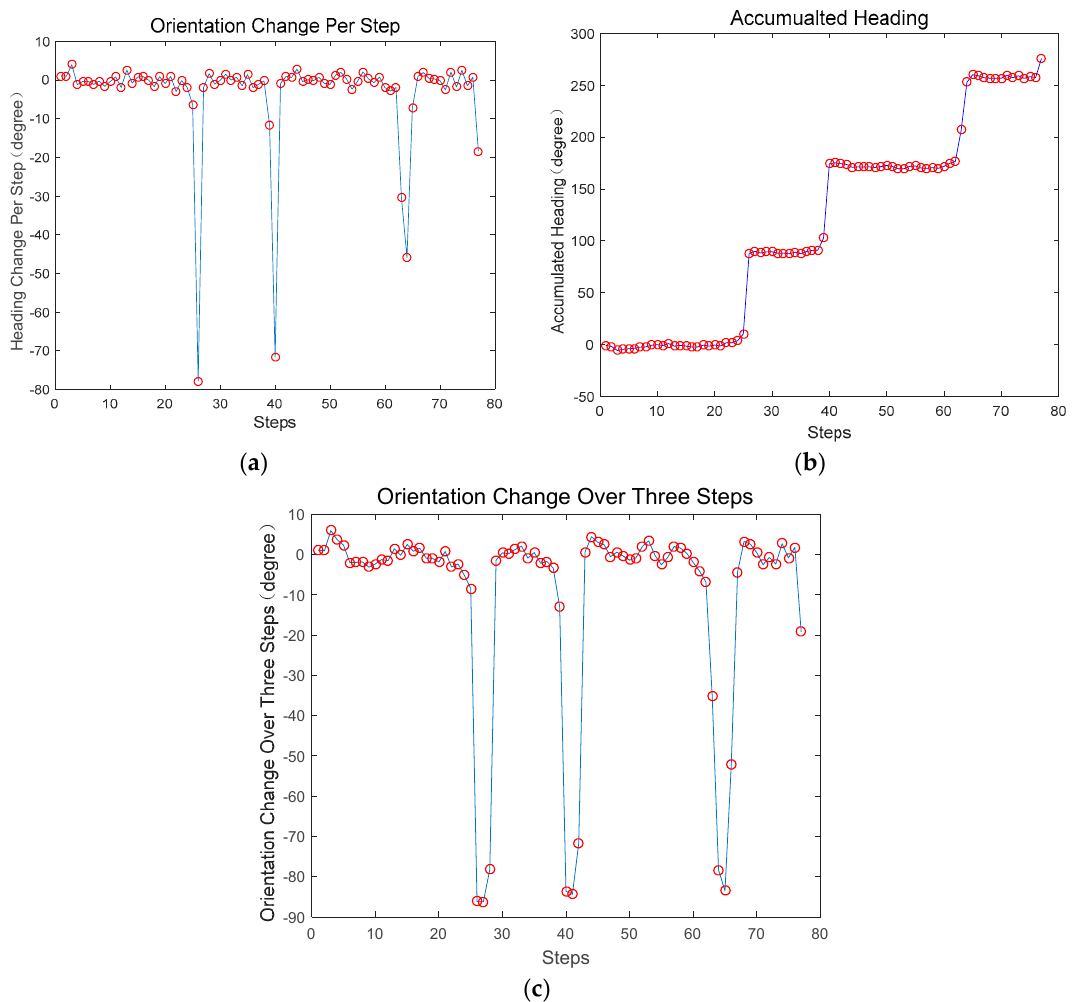
Figure 3. Orientation estimation result from the gyroscope: ( a ) orientation change during every step; ( b ) accumulated heading estimation with respect to the starting orientation (magnetic north); and ( c ) orientation change over three steps.